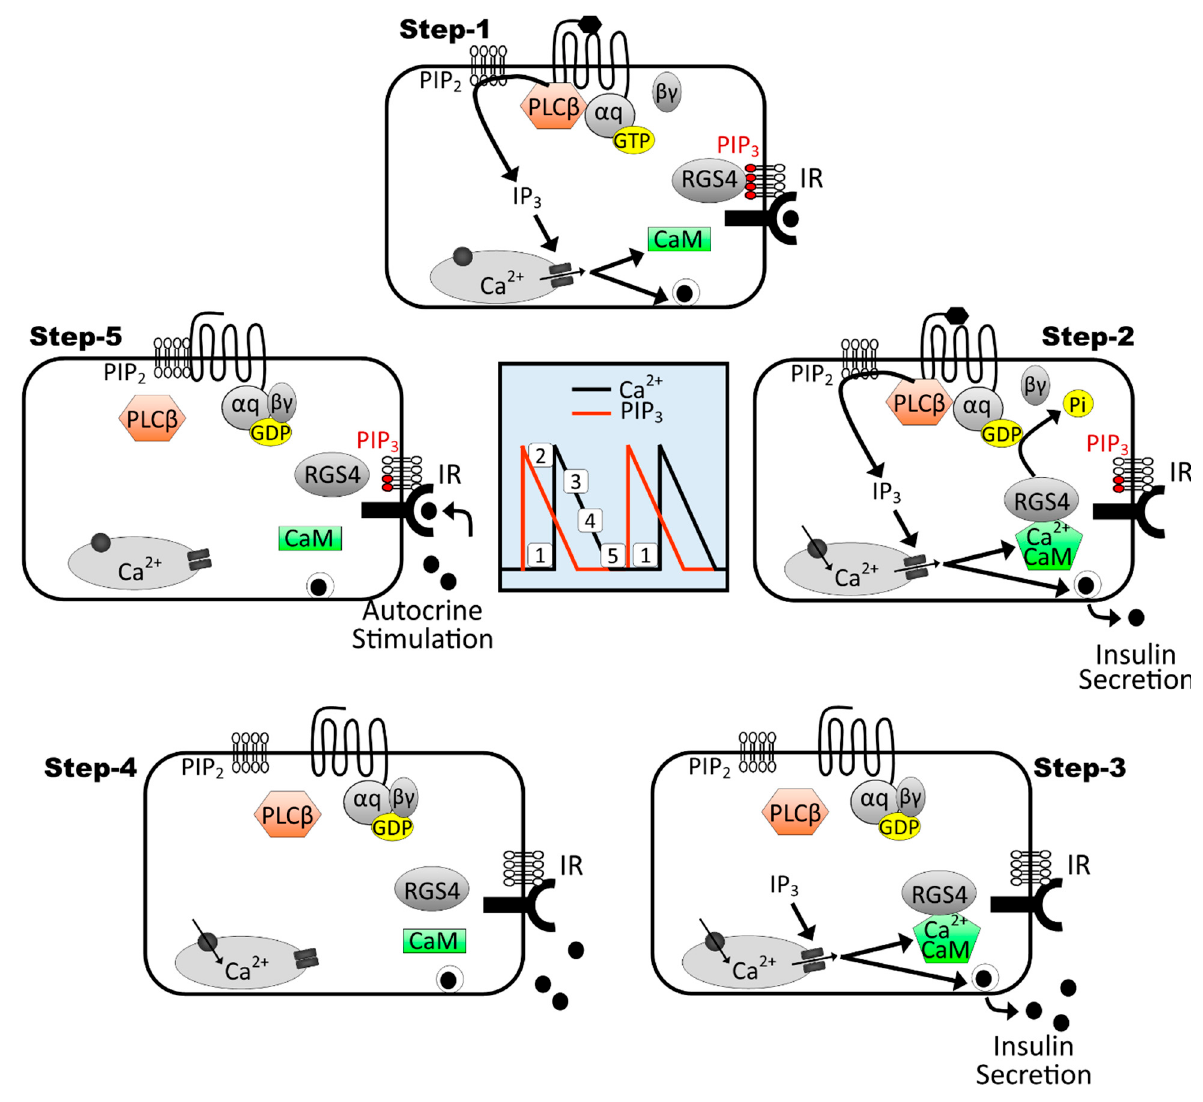
Figure 9. Model for RGS4-mediated control of calcium oscillations in the context of oscillatory insulin receptor-dependent PI3K/PIP3 signaling. This 5-step model extends on previous work from Luo et al. 2001 [78], showing the importance of RGS4/PIP3/Ca 2+ -calmodulin cycling to promote Gq-mediated intracellular calcium oscillations in secretory cells. Central panel shows interspersed timing of intracellular calcium (black trace) and PIP 3 (red trace) oscillations in a β -cell marked with the relative positions of mapped steps 1–5. Moving clockwise through the steps reveals how the RGS4 inhibition by PIP 3 and activation by Ca 2+ -calmodulin can lead to oscillatory Gq-mediated calcium oscillations in glucose-stimulated β -cells. Moreover, since intracellular calcium oscillations promote oscillatory insulin secretion, we propose that insulin receptor-dependent PIP 3 produced via autocrine signaling may contribute to perpetuation of the intracellular Ca 2+ (and possibly cAMP) cycling in β -cells.